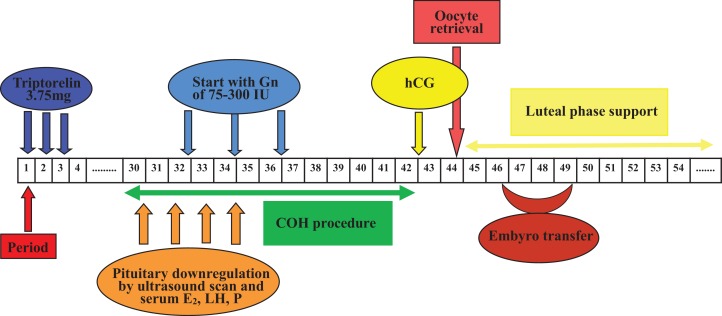
Flow chart of GnRH agonist prolonged regimen in Group 1.One depot of 3.75 mg Triptorelin was injected from 1st to 3rd days of the menstrual cycle, in which ovarian stimulation with 75–300 IU Gns would start 32–38 days later along with confirmation of pituitary downregulation. COH procedure was adjusted according to patients’ ovarian response. One dose of hCG was given when at least two follicles reached 18 mm in mean diameter, and then oocytes were retrieved 34–36 h later. After that, embryo transfer was performed 2–5 days later. Luteal phase support was sustained from the day of oocyte retrieval. (COH, controlled ovarian hyperstimulation; E2, estradiol; Gns, gonadotropins; hCG, human chorionic gonadotrophin; LH, luteinizing hormone; P, progesterone).